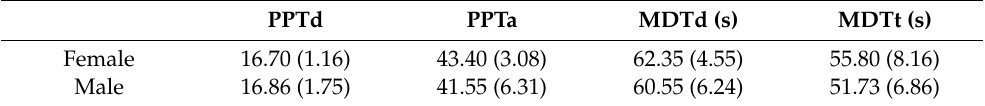
Table 2. Mean (SD) scores of the PPT and